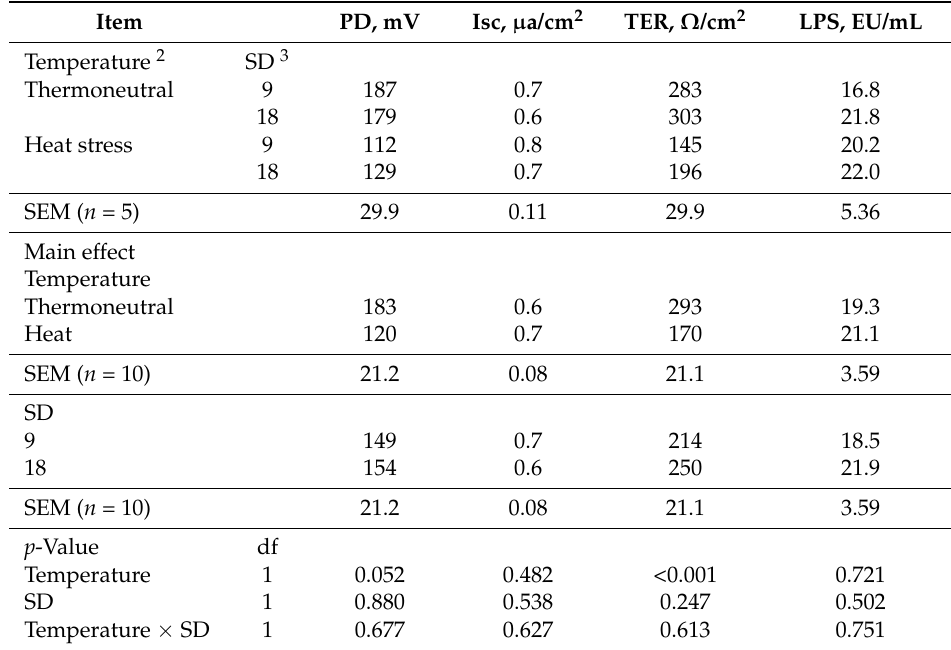
Table 4. Effect of heat stress and stocking density on intestinal permeability 1 in the jejunum of growing broiler chickens.